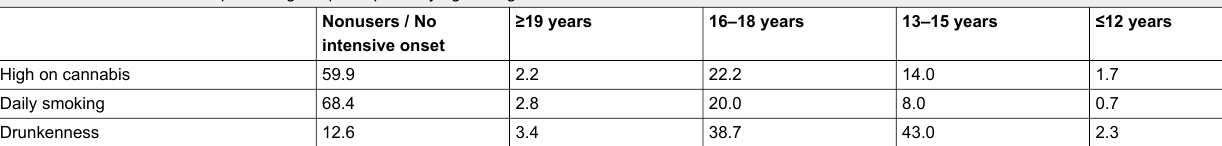
Table 3 : Intensive use onset: percentage of participants by age